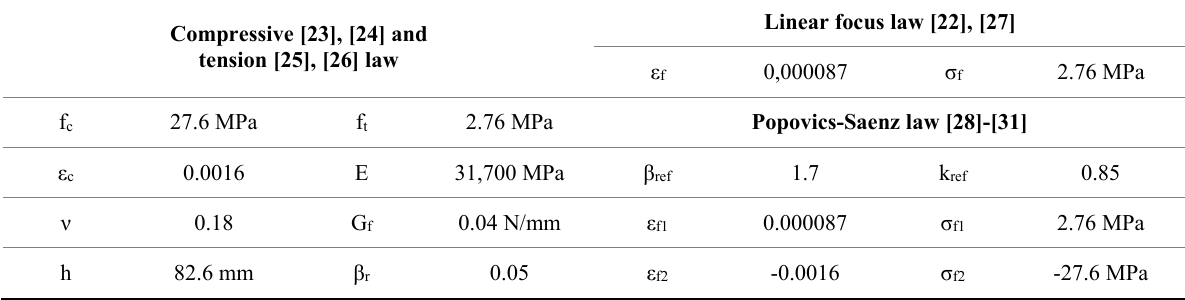
Table 2. Material parameters: direct